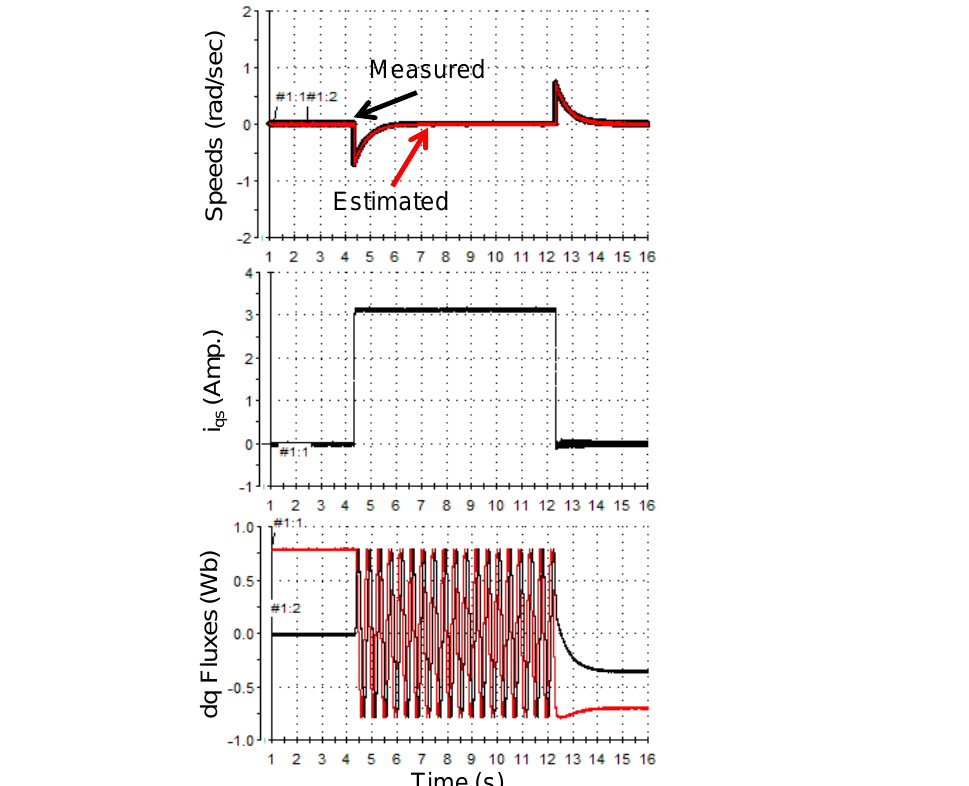
Figure 19. Simulation tests at speed reference of 0 p.u (0 rd/s) with rated load torque change of +7 N.m applied at t = 4 s and removed at t = 12 s.